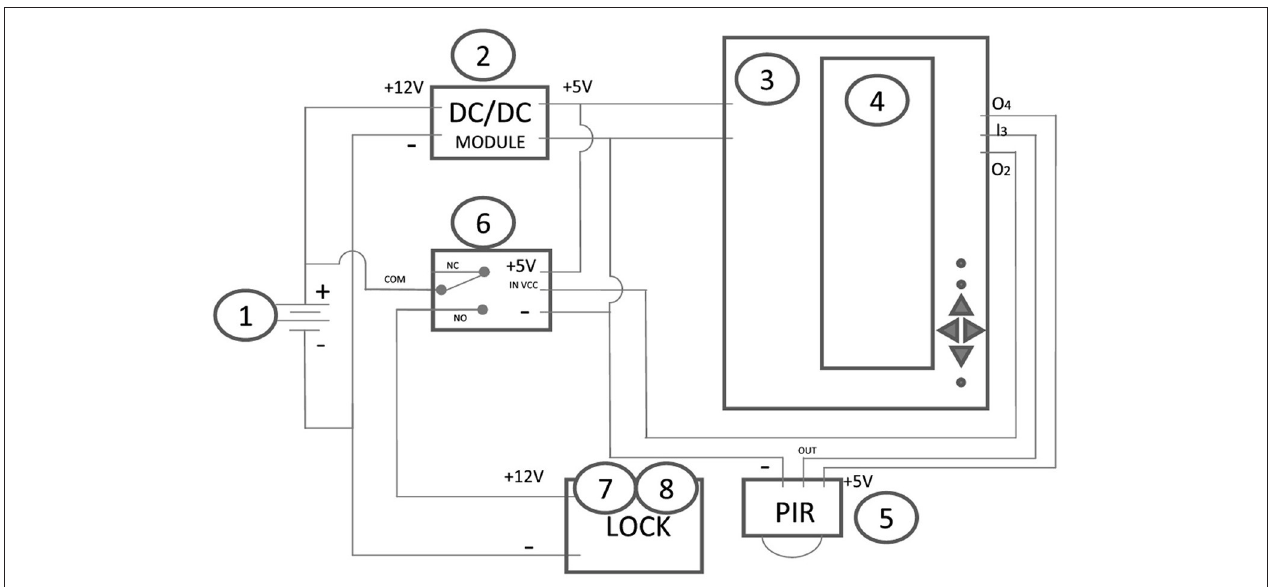
FIGURE 4 | Electric diagram of the trap: (1) battery 12V/7AH; (2) DC LM2596 module; (3) Arduino Leonardo ATmega32u4 R3; (4) LCD keypad shield LCD 1602; (5) PIR HC SR-501; (6) relay; (7) actuator (car central lock actuator); (8) lock (car trunk lock).